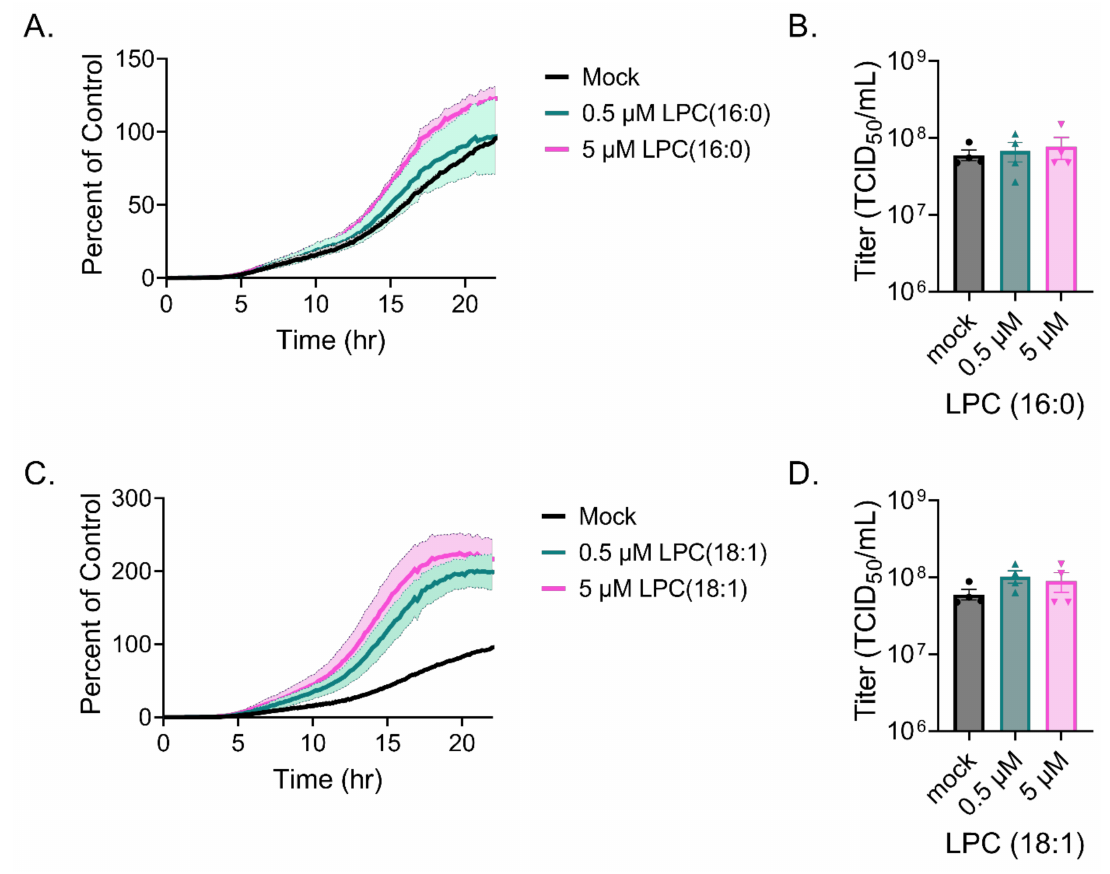
Figure 5. LPC supplementation during VSV infection. Vero cells were infected with VSV-nLuciPest, and cell-to-cell spread kinetics were monitored for 24 h with supplementation of LPC 16:0 ( A ) or 18:1 ( C ). Titers were determined at 24 h after supplementation with LPC 16:0 ( B ) or 18:1 ( D ) by performing serial dilutions and calculating the TCID50 using the Spearman–Karber